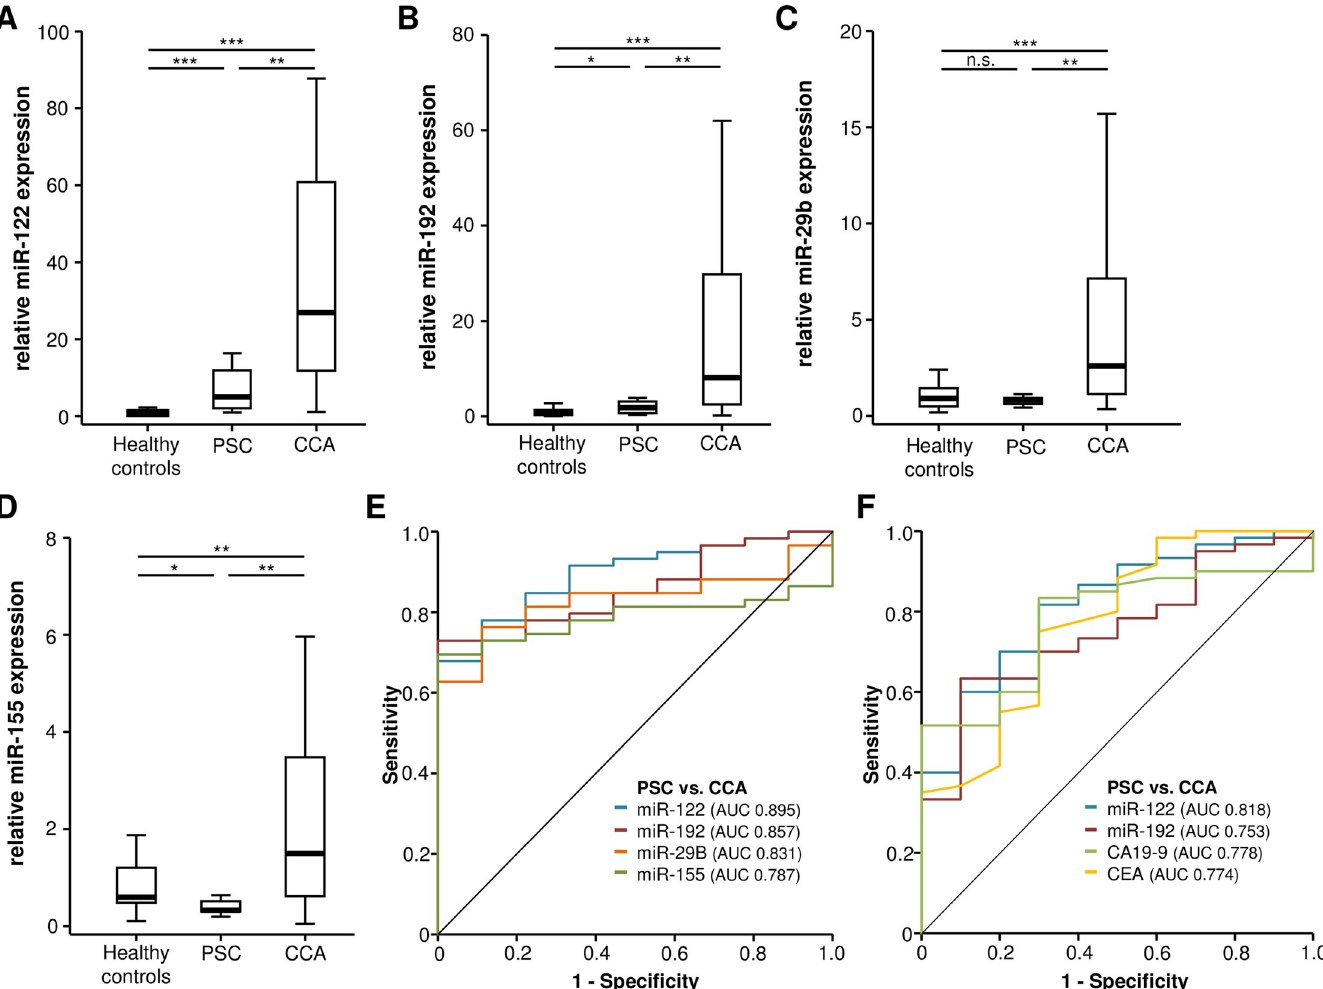
Fig 2. Circulating levels of miRNAs can discriminate between benign and malignant hepatobiliary disease. Serum levels of miR-122 (A) and miR-192 (B) are significantly elevated in PSC patients compared to healthy controls but significantly lower compared to CCA patients (U-Test). PSC patients show similar levels of miR- 29b (C) and decreased levels of miR-155 compared to healthy controls (D, U-Test). ROC curve analysis reveals that miR-122 has the highest AUC value for the discrimination between PSC and CCA patients (E). miR-122 and miR-192 show comparable AUC values when compared to standard tumor markers of CCA such as CEA and CA19-9 (F, DeLong